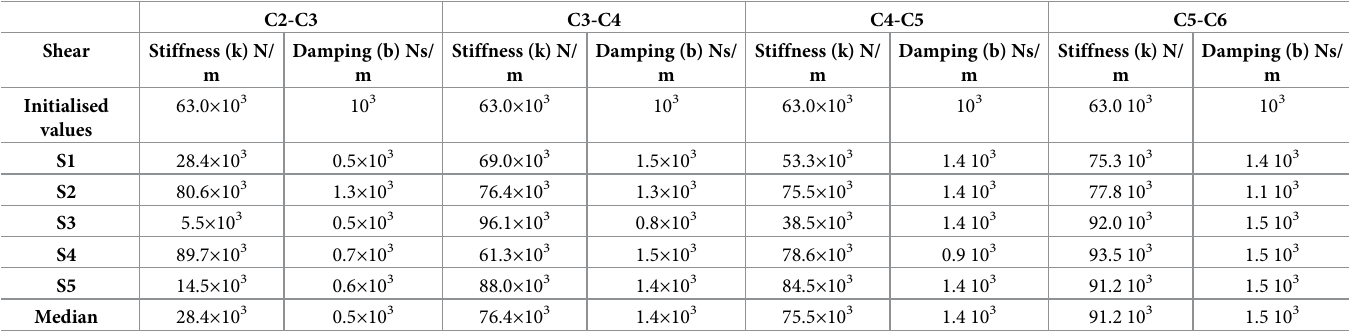
Table 3. Shear stiffness (k) and damping (b) parameter values identified for each specimen specific model of the spinal specimens